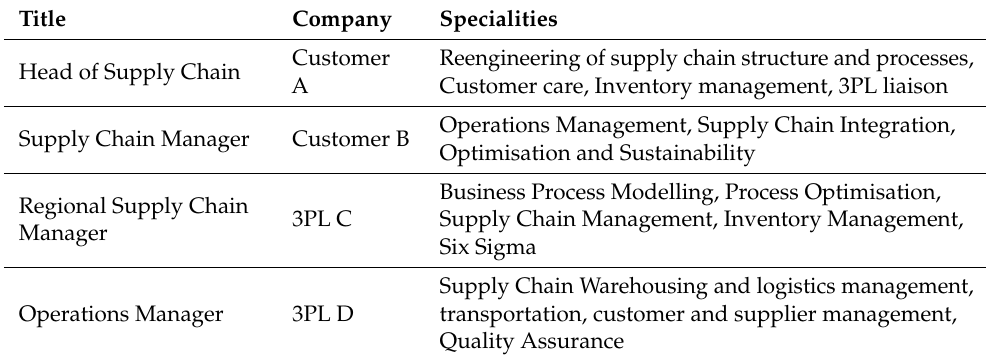
Table 1. Respondents’